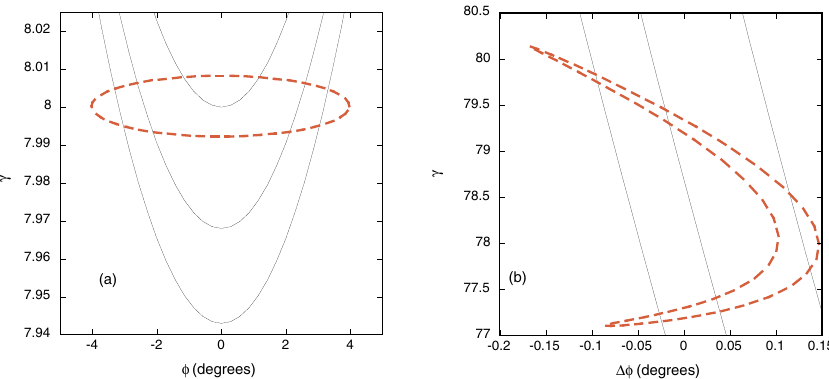
FIG. 19. (Color) (a) Phase contours (solid lines) intersecting an ellipse (dashed line) representing the injected beam distribution. (b) Phase contours (solid lines) and extracted beam phase space (dashed line) obtained by integrating Eqs. (13) and (14) for points on the injected beam